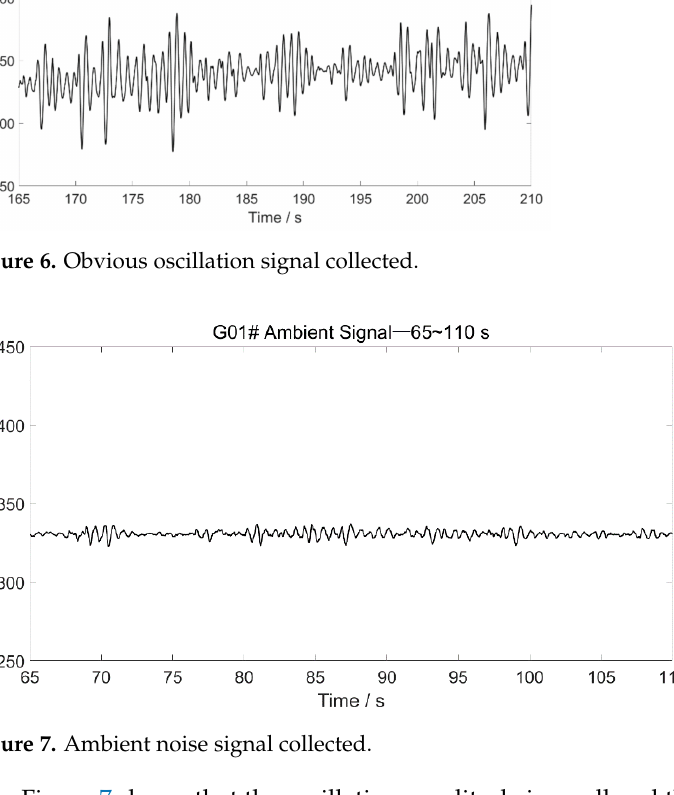
Figure 8. Intrinsic mode functions (IMFs) extracted from the obvious oscillation signal. Figure 7. Ambient noise signal collected. Table 2. Modal identification of the obvious oscillation signal.